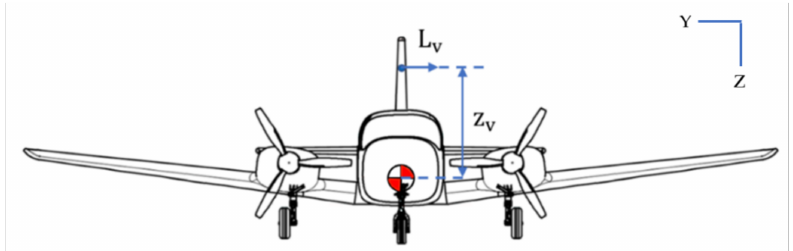
Figure 4. Aircraft in sideslip, β , with an offsetting rolling moment,